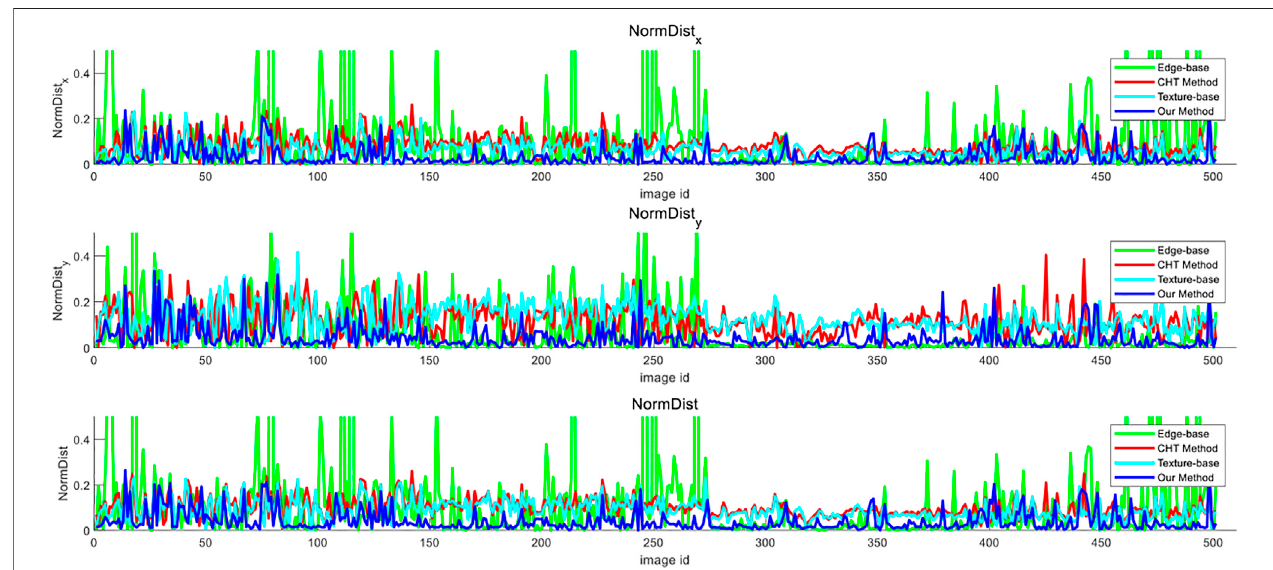
FIGURE 10 | Comparison of error curves of different vanishing point detection methods.